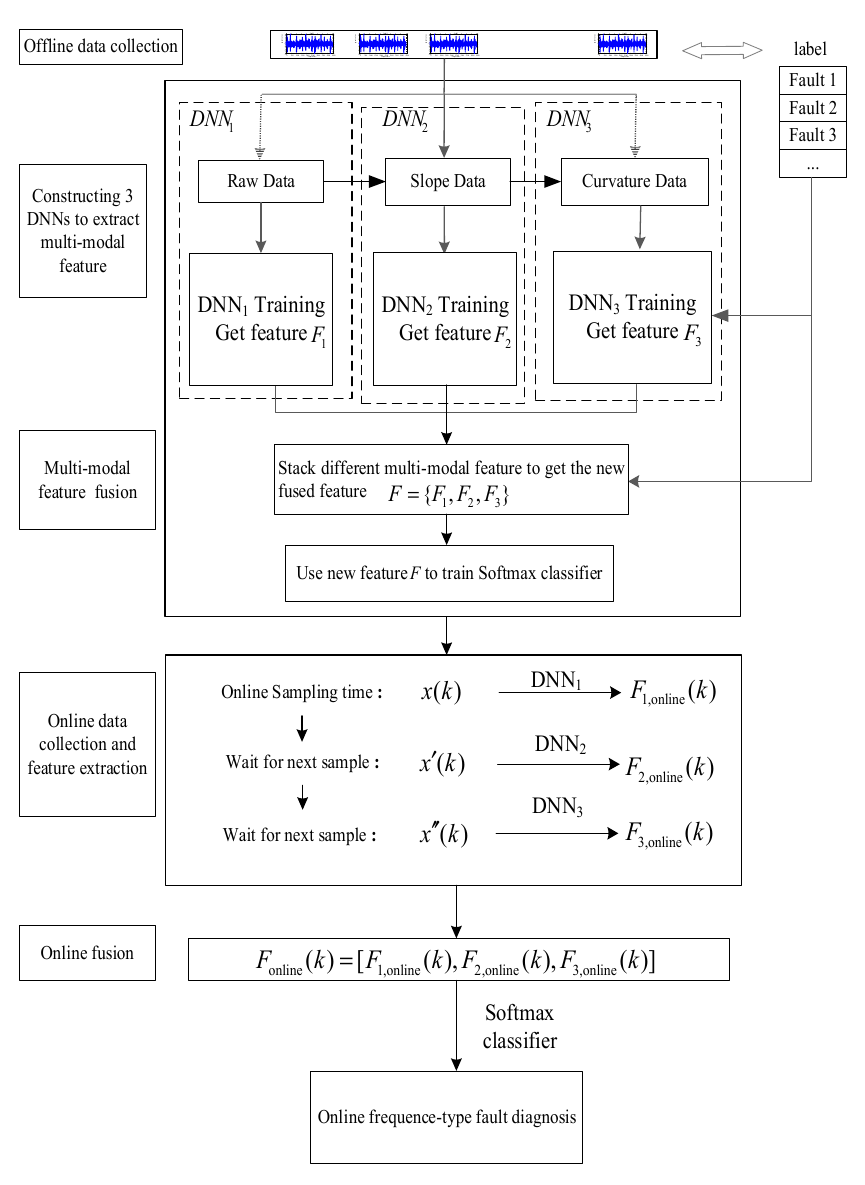
Figure 6. Feature fusion process.